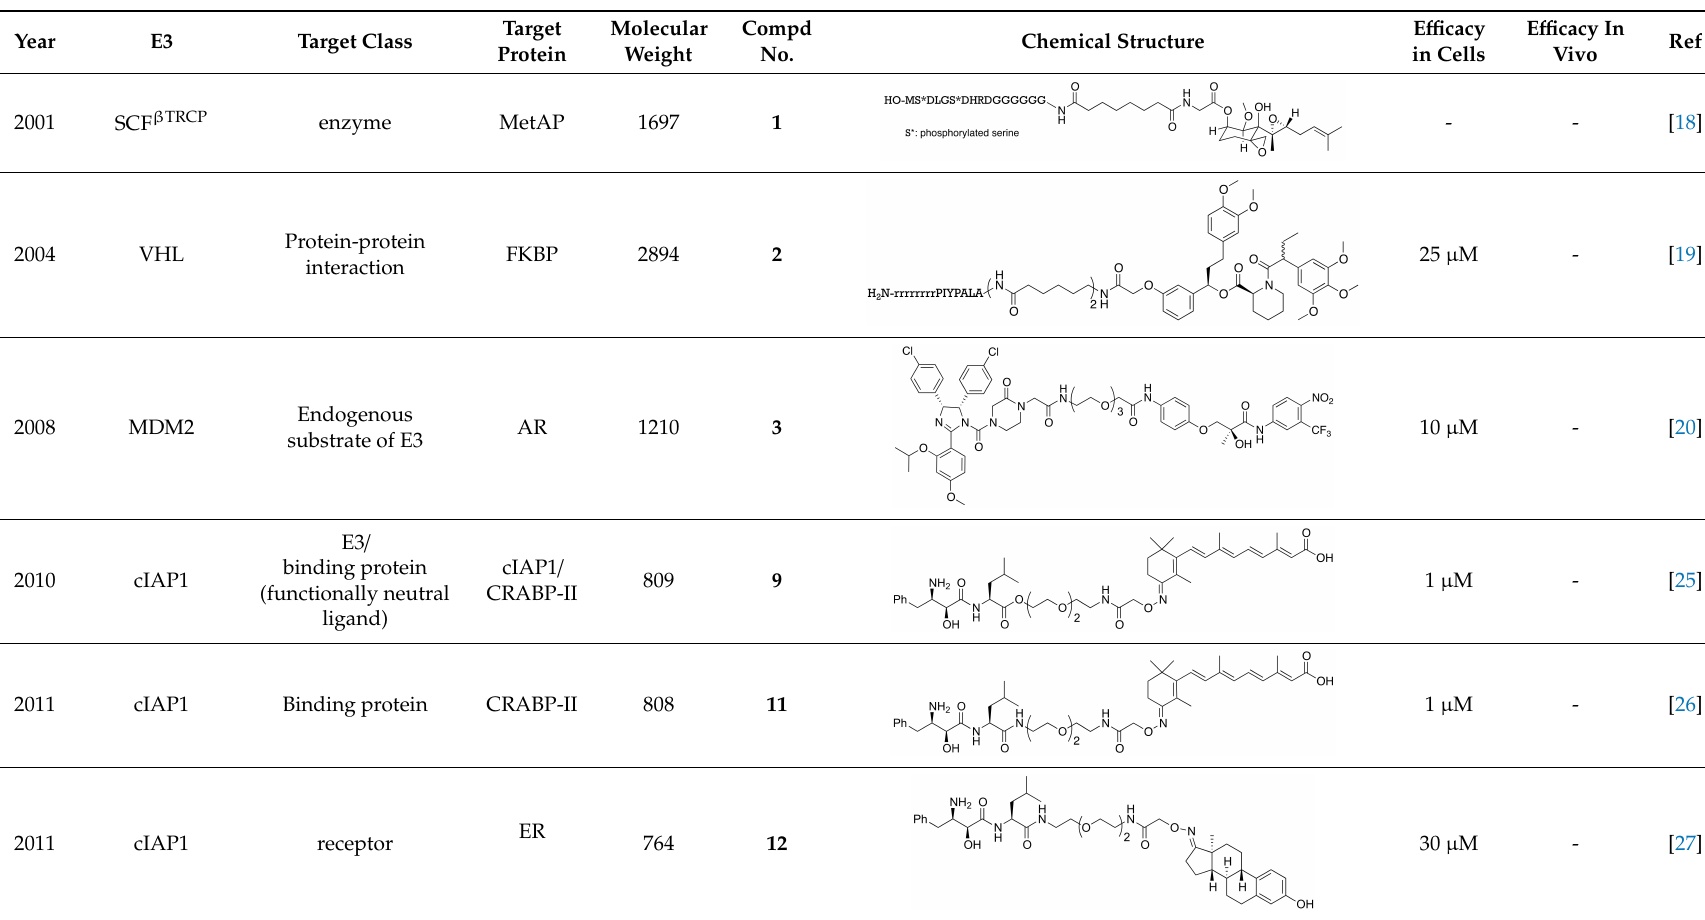
Table 1. Timeline, chemical structures, and biological activities of IAP-mediated protein degraders along with other representative E3-mediated protein